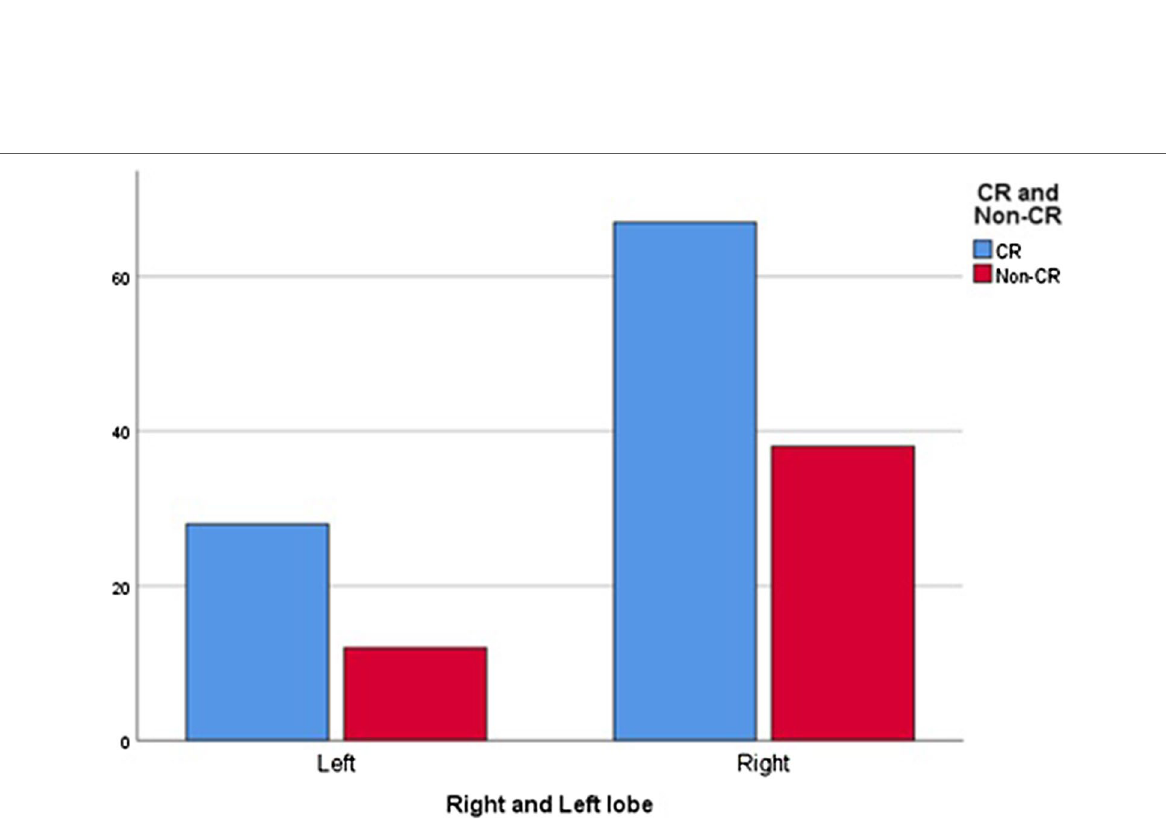
Fig. 5 Bar chart showing the association between the lobe of the tumor and CR and non-CR groups, no significant difference ( P